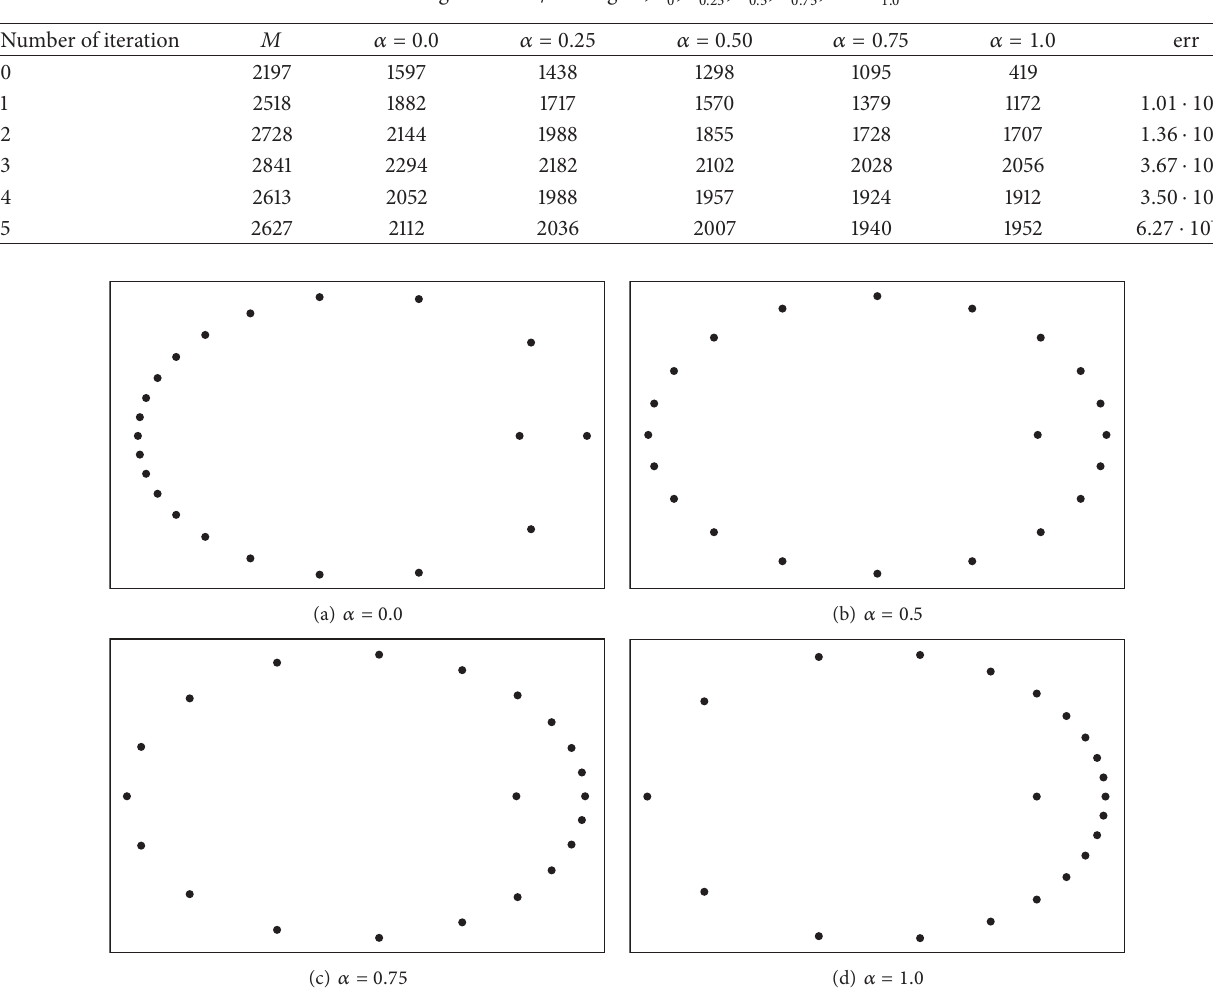
Table 1: Length of the 1/Δ using 𝑀, Ψ 0 , Ψ 0.25 , Ψ 0.5 , Ψ 0.75 , and Ψ 1.0 .